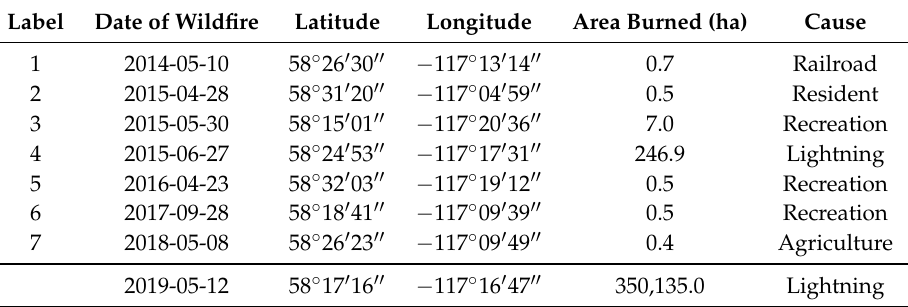
Figure 2. A weighted average of EVI images as a proxy for the vegetation coverage during 2013–2019 with a photograph by the Government of Alberta taken in May 2019. The details of the numerically labeled locations in the EVI image are shown in Table 1. The top-right panels show parts of a satellite image clipped to the polygon shapefiles of the burned areas in locations 3 and 4. Pixels A, B, and C are also selected to further investigate the changes in 2019. Table 1. Validation data within the study region provided by the Government of Alberta. Each location (before 2019), is shown by an asterisk (labeled) in Figure 2, impacted by